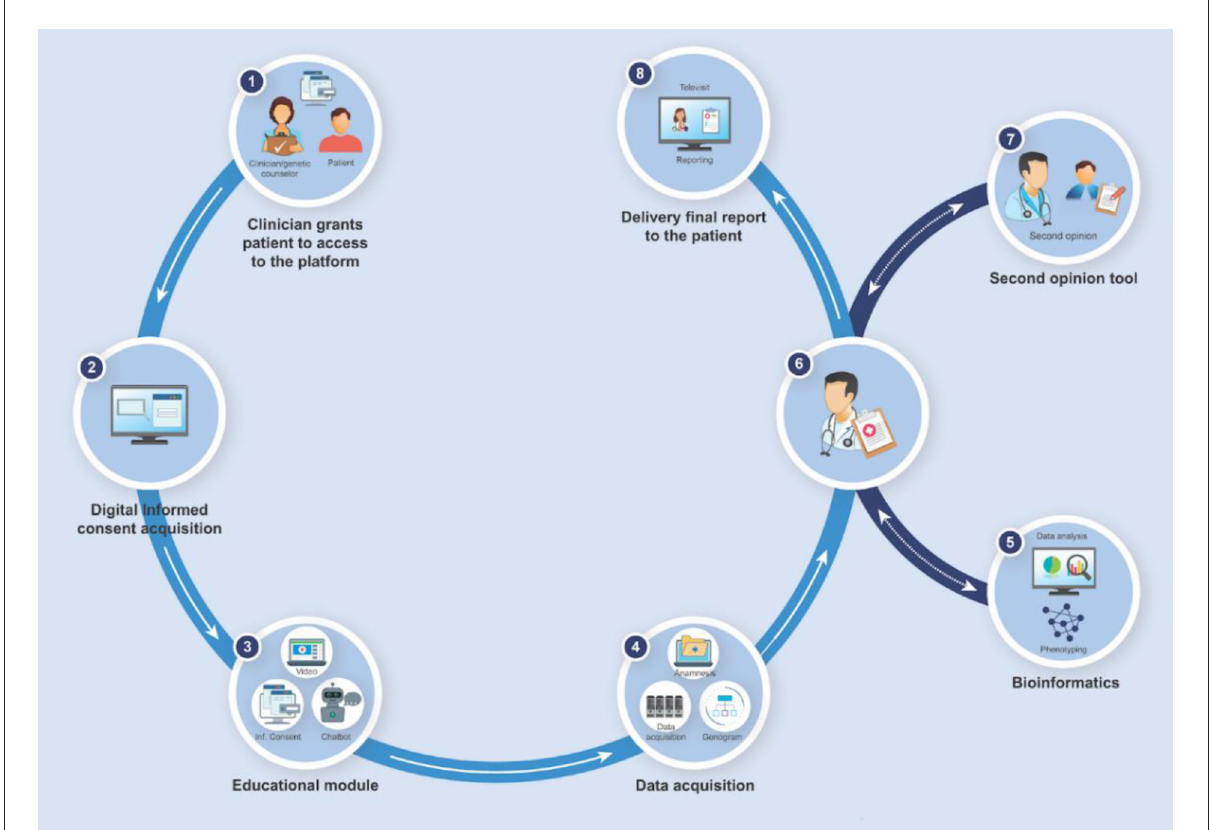
FIGURE1 Workflow map of the digitalized steps on a GC service. (1) The access to the private area is allowed only by one-time password (OTP); (2) The platform manages the dematerialized Informed Consent through eSignature; (3) The “Training” module focuses on the basis of genetics: patients can query “Gene-bot,” a virtual assistant ad-hoc built for answering on diseases due to DNA mutations; (4) Through a simple and guided procedure, the user provides personal and familiar data (including also the pedigree) which will be then acquired by the specialist; (5) Genome Access provides the specialist with advanced bioinformatics applications for data analysis and phenotyping; (6) The platform guides the specialist on the prescription step, with the possibility of (7) engaging a colleague for a specific second opinion consultation; (8) Thanks to the “Televisit” module, integrated within the platform, it is possible to assist patients remotely and optimize the clinical